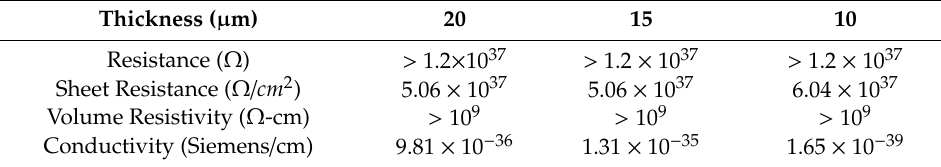
Table 4. Electrical properties for the NDG